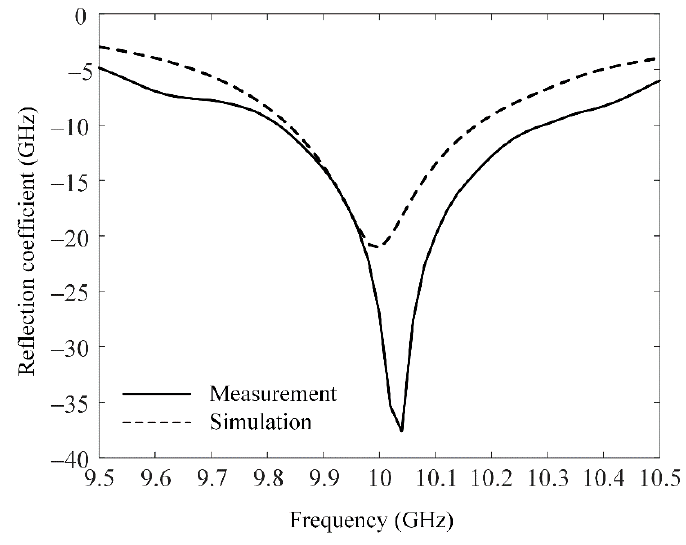
Figure 3. Reflection coefficients of the proposed antenna.